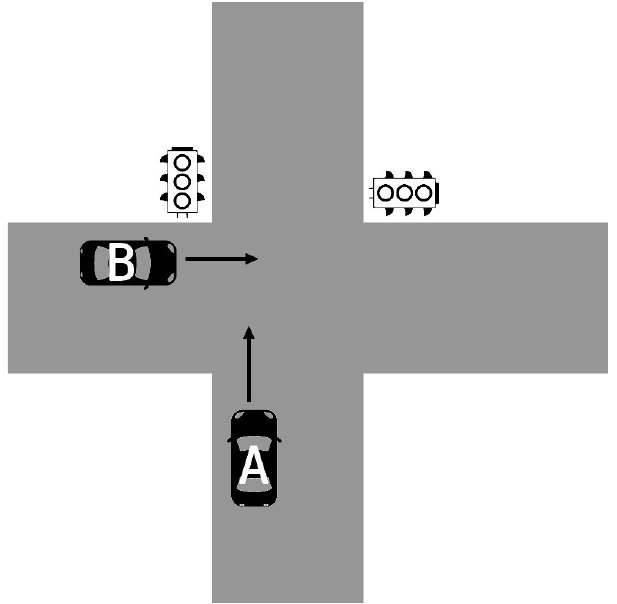
Figure 4. Illustration of a crash involving two vehicles at an intersection with traffic lights in Japan (left side